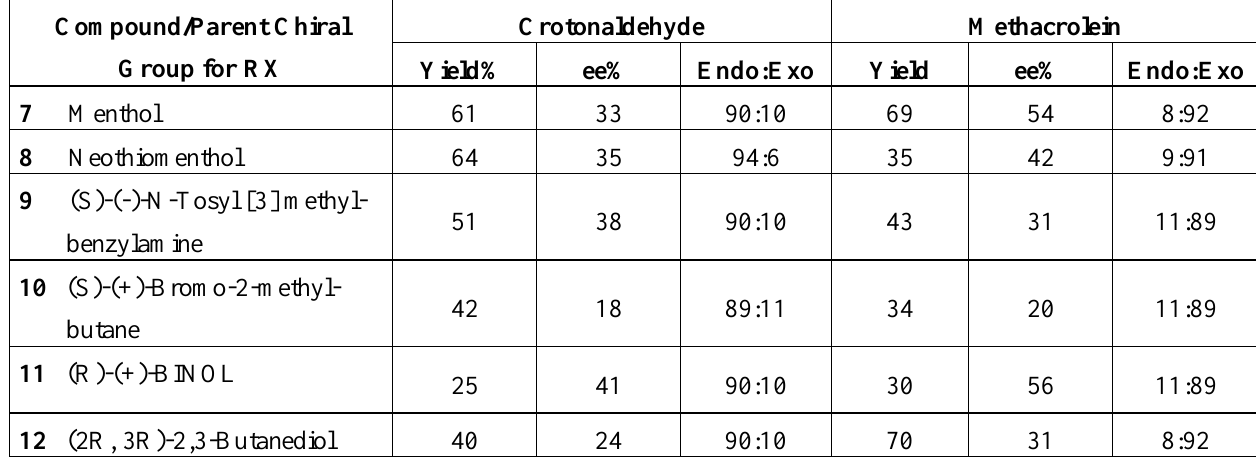
Crotonaldehyde MethacroleinCompound/Parent